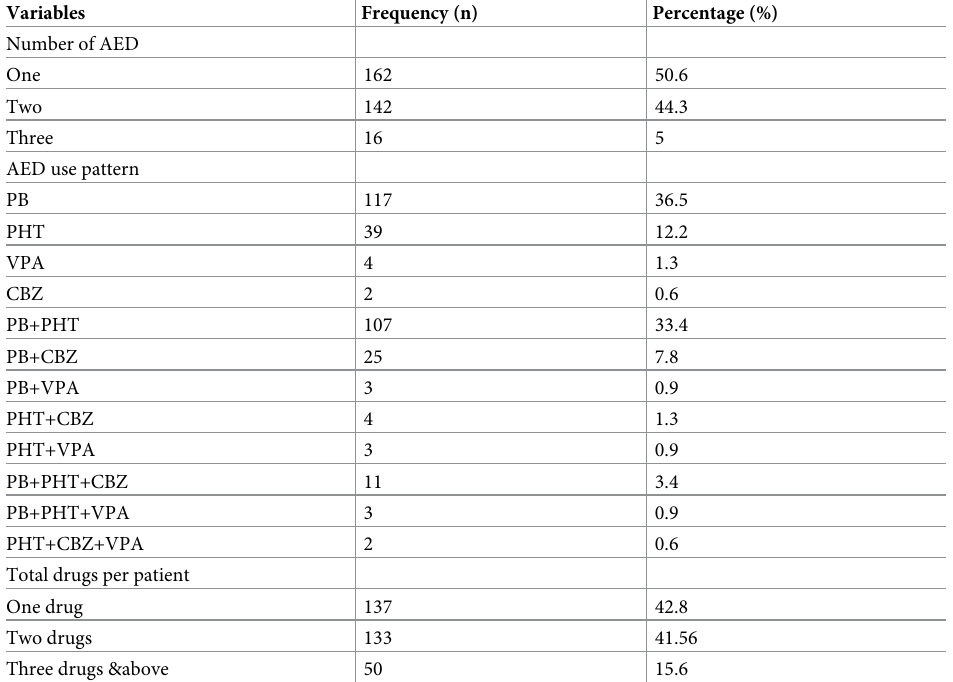
Table 3. Medication use pattern of epileptic patients attending ambulatory clinic of JUMC,